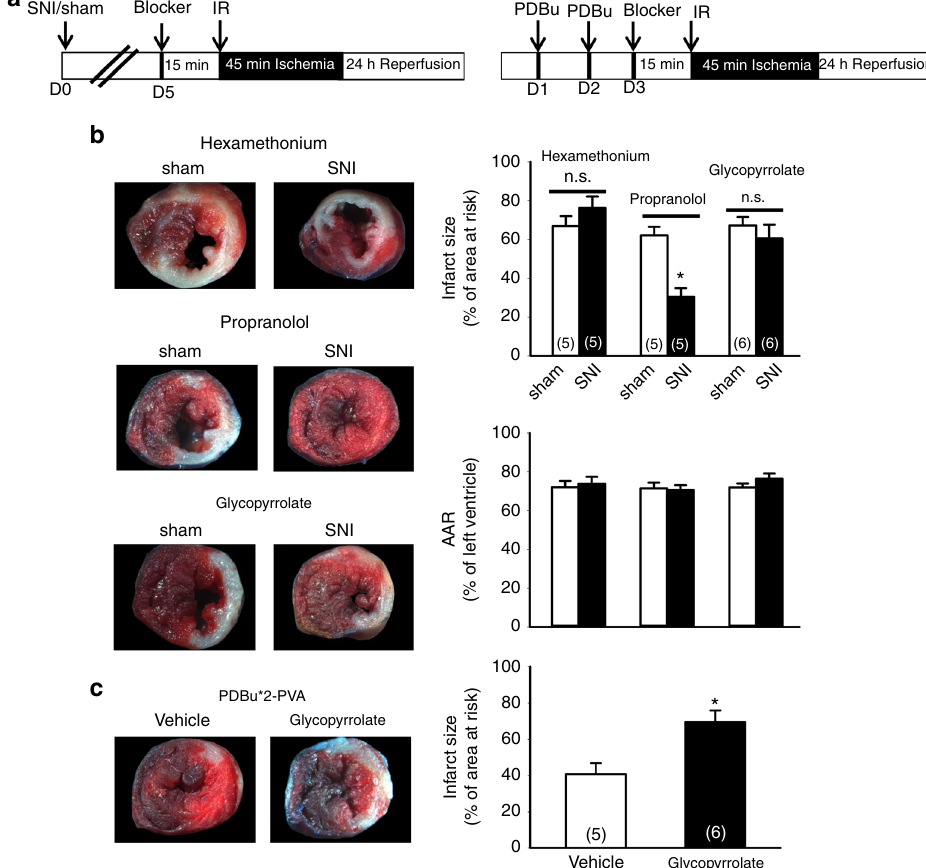
Fig. 8 Parasympathetic but not sympathetic blockers prevent SNI-induced and PVA PDBu infusion-induced cardioprotection. a Schematic of experimental design showing the timeline for SNI surgery (D0), i.v. infusion of blockers (D5), and myocardial IR surgery (D5) ( left panel ). Right panel shows the timeline for PVA PDBu infusion (D1, D2), i.v. infusion of blockers (D3), and myocardial IR surgery (D3). b Representative images of TTC staining in heart cross- sections from different treatment groups ( left panels ). Quanti fi cation results of infarct size and AAR in cardiac sections different groups ( right panels ). Hexamethonium (30 mg/kg), propranolol (2 mg/kg), glycopyrrolate (0.4 mg/kg) were infused i.v. 15 min prior to myocardial ischemia surgery in mice received sham or SNI surgery. * p < 0.05 vs. sham group. Hexamethonium and glycopyrrolate but not propranolol prevented SNI-induced cardioprotection. c Representative images of TTC staining in heart cross-sections in mice treated with vehicle or glycopyrrolate ( left panels ). Quanti fi cation results of infarct size in cardiac sections ( right panels ). * p < 0.05 vs. vehicle group. Error bars indicate SEM. Statistical signi fi cance was determined by Student ’ s t- test ( b , c